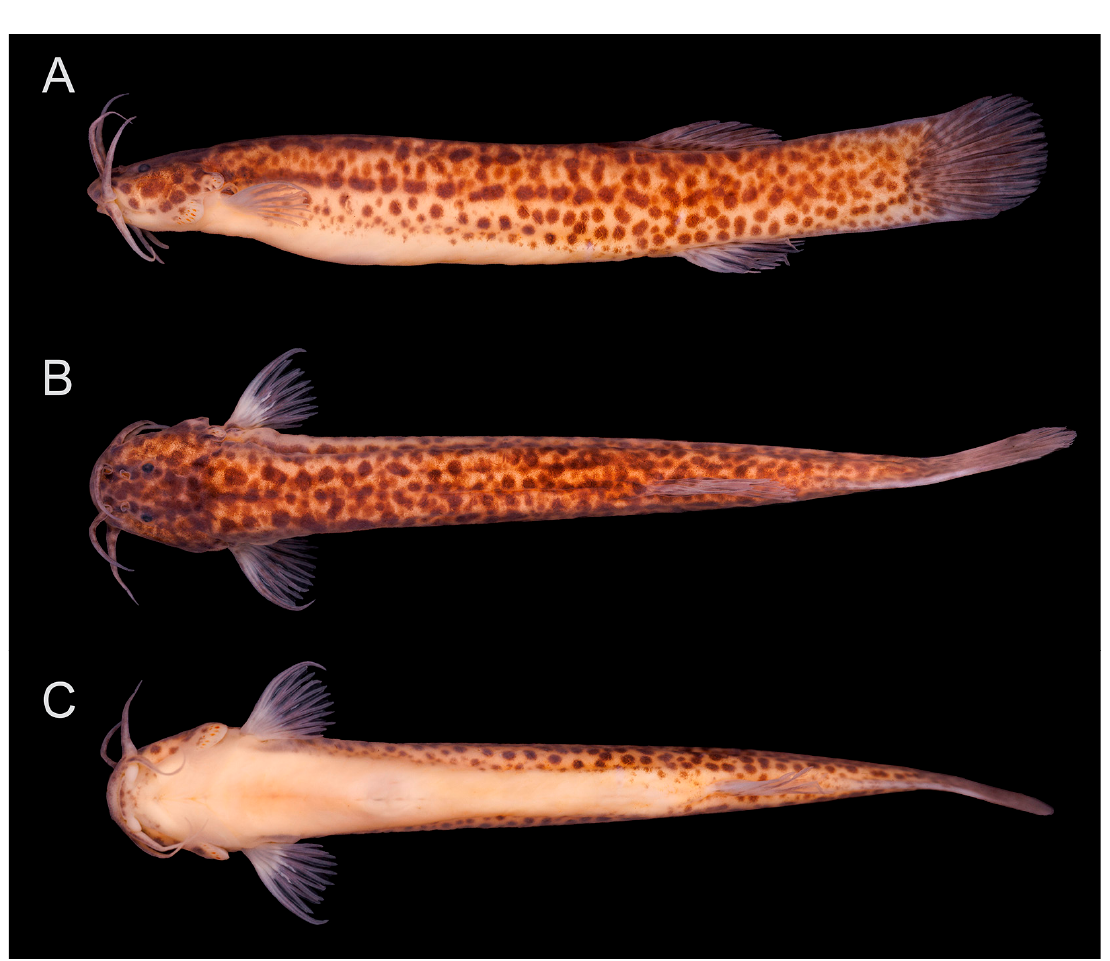
Figure 12. Trichomycterus ( Cryptocambeva ) uberabensis Costa, Azevedo-Santos & Katz sp. nov. Holotype, UFRJ 13366, Veríssimo, 42.3 mm SL: ( A ) lateral, ( B ) dorsal, and ( C ) ventral views.